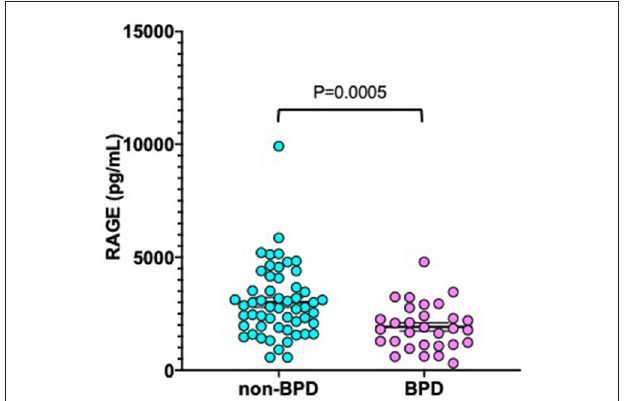
for sepsis, necrotizing enterocolitis, confounding effects of organ injuries such as acute kidney injury or intracranial hemorrhage, and feeding or nutritional deficits. Further study including samples at other time points, such as 28 days of life or a corrected 36-week gestational age would be better to establish whether sRAGE is associated with various factors related to